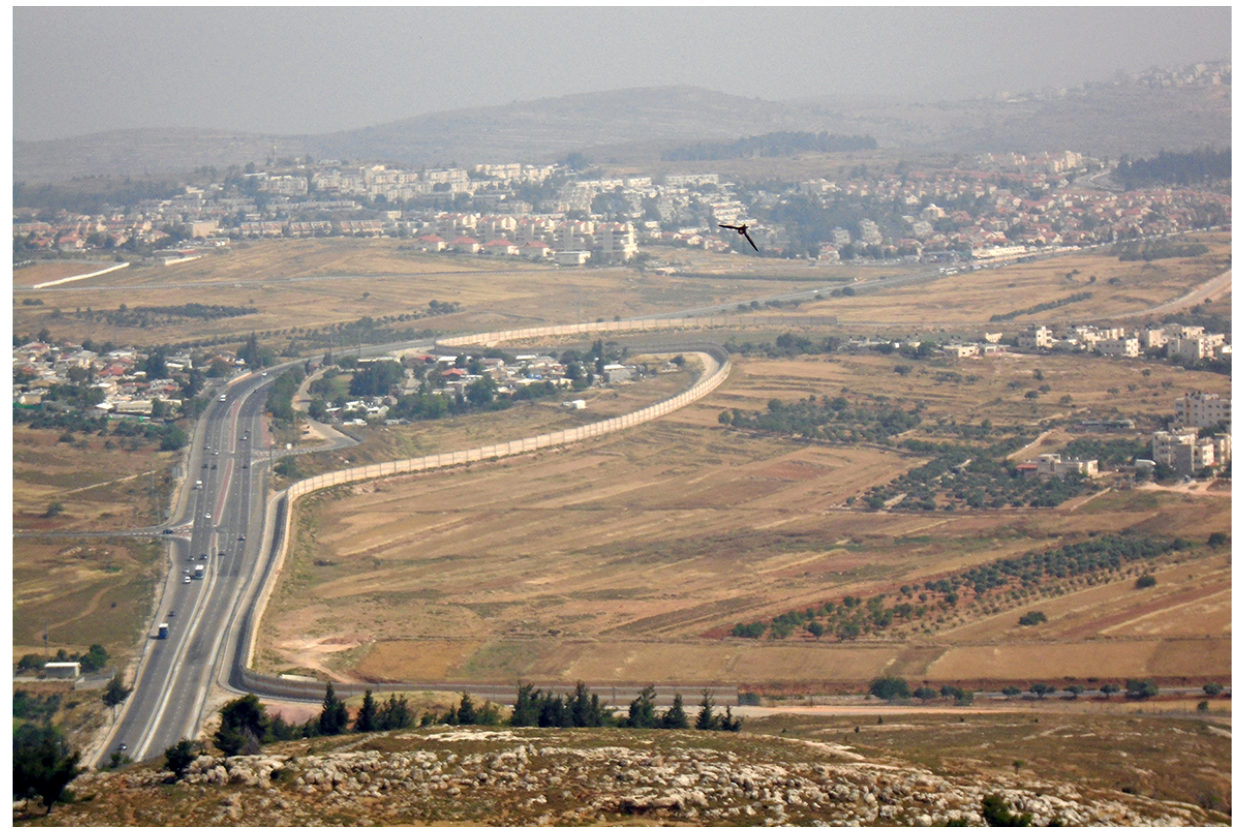
Figure 4. Separation wall cutting through the Palestinian